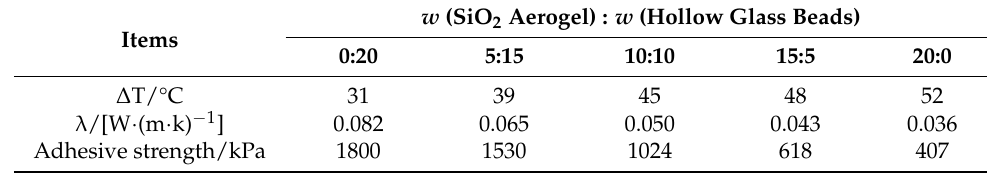
Table 3. Effect of heat insulation filler ratio on coating properties.